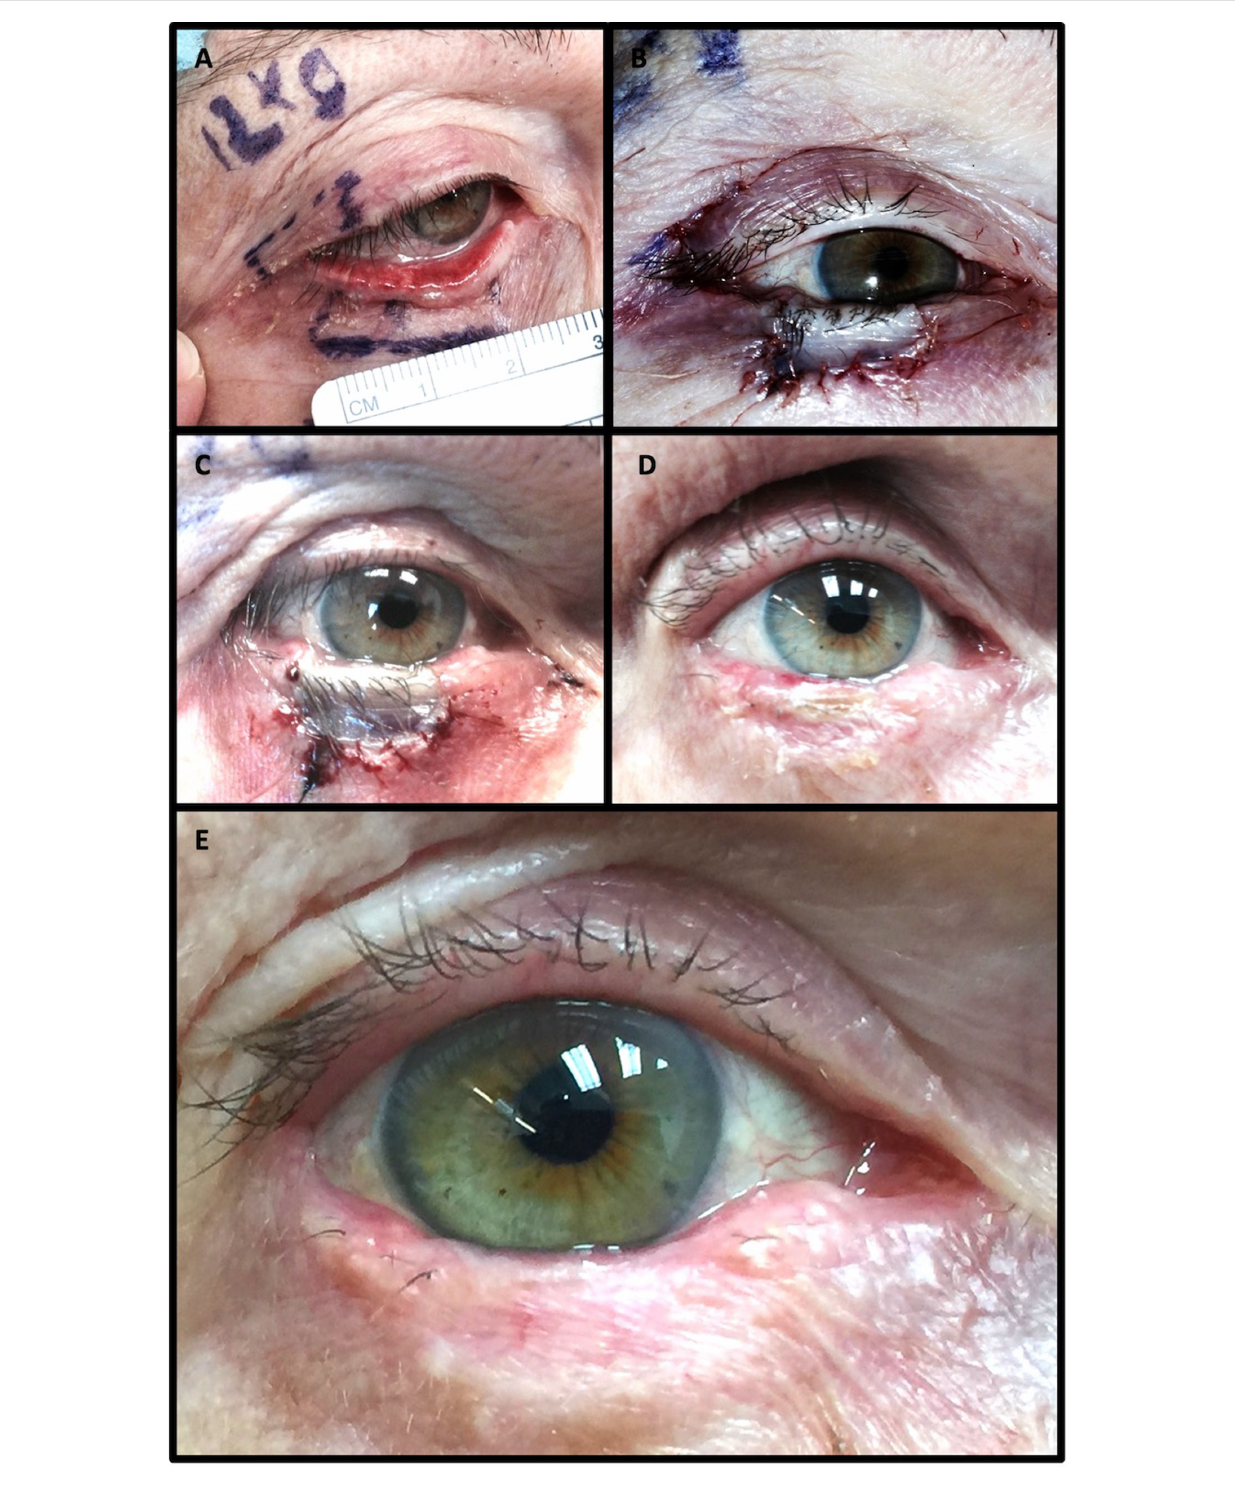
FIGURE 3 Healing phases of right-upper to right-lower FBA. ( A ) Pre-operative markings. ( B ) White phase immediately post-FBA. ( C ) Blue phase 4 days post-FBA. ( D ) Pink phase 1.5 months post-FBA. ( E ) Final outcome 6 months